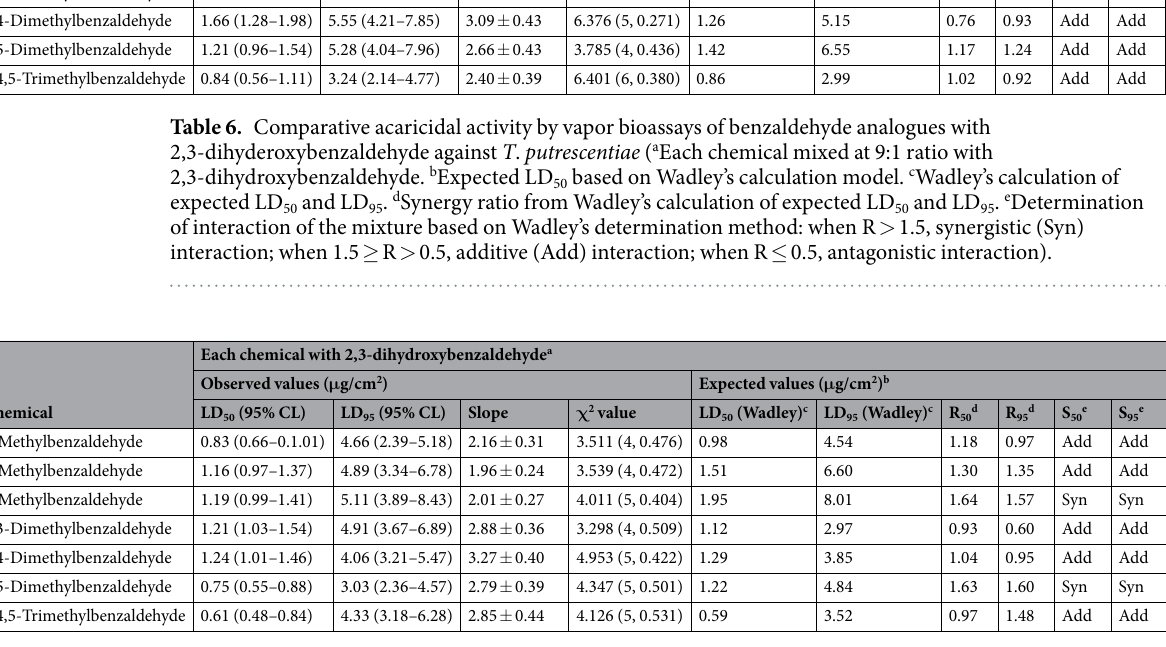
Table 7. Comparative acaricidal activity by contact bioassays of benzaldehyde analogues with 2,3-dihyderoxybenzaldehyde against T . putrescentiae ( a Each chemical mixed at 9:1 ratio